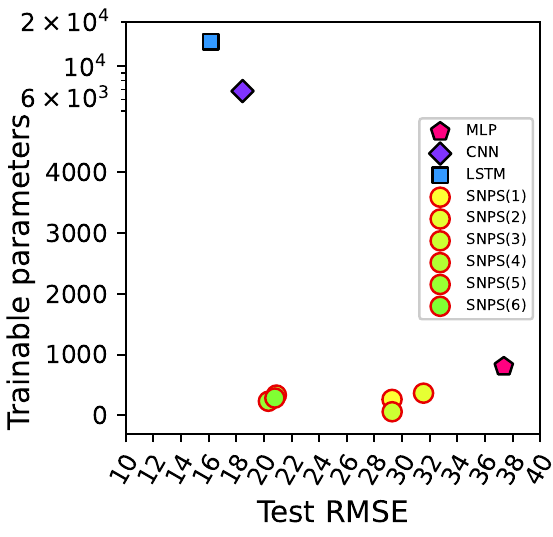
Figure 6. Trade-off between test RMSE and number of trainable parameters for the methods consid- ered in the experimentation on CMAPSS (FD001).